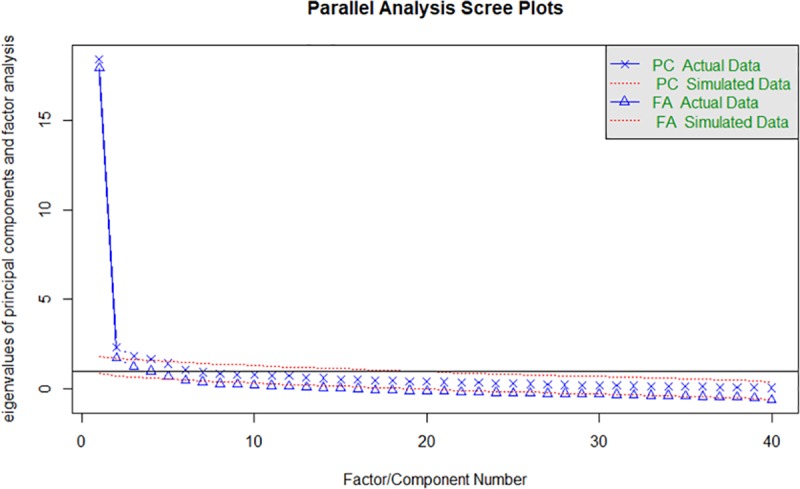
Parallel analysis scree plot of eigenvalues.Scree plot of actual and simulated data for factor analysis (FA) and principal component (PC) analyses.